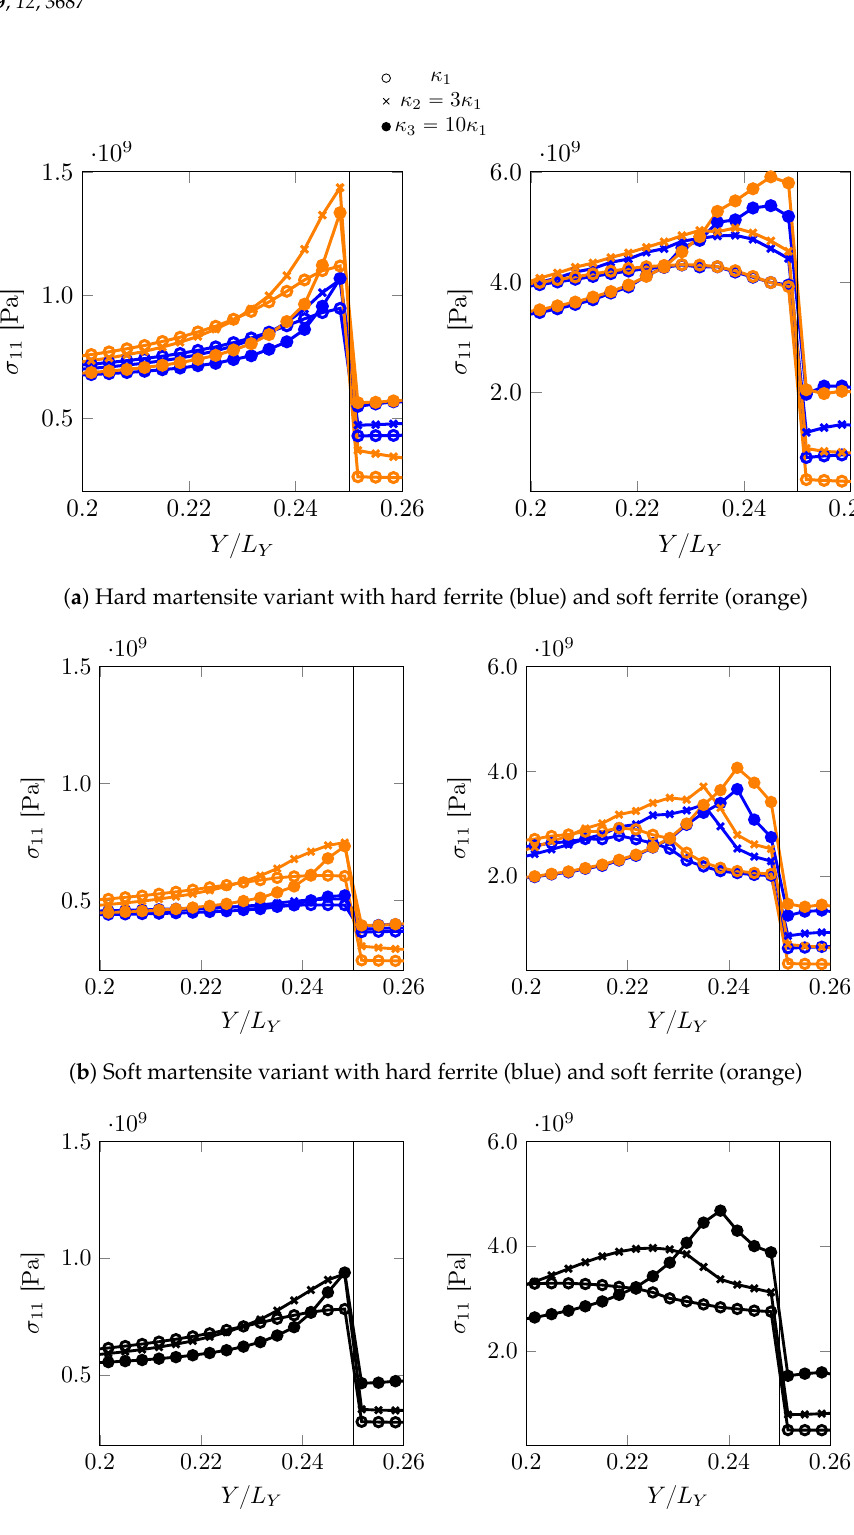
L X /2 N X , ahead of the curved phase boundary Figure 8. σ 11 distribution profiles (along X = − at ( 0,0.25 L Y ) and extending into the ferrite zone) profiles for different martensite variant-ferrite combinations at two different overall deformation levels, ¯ F 11 = 1.00125 ( left column) and ¯ F 11 = 1.00875 ( right